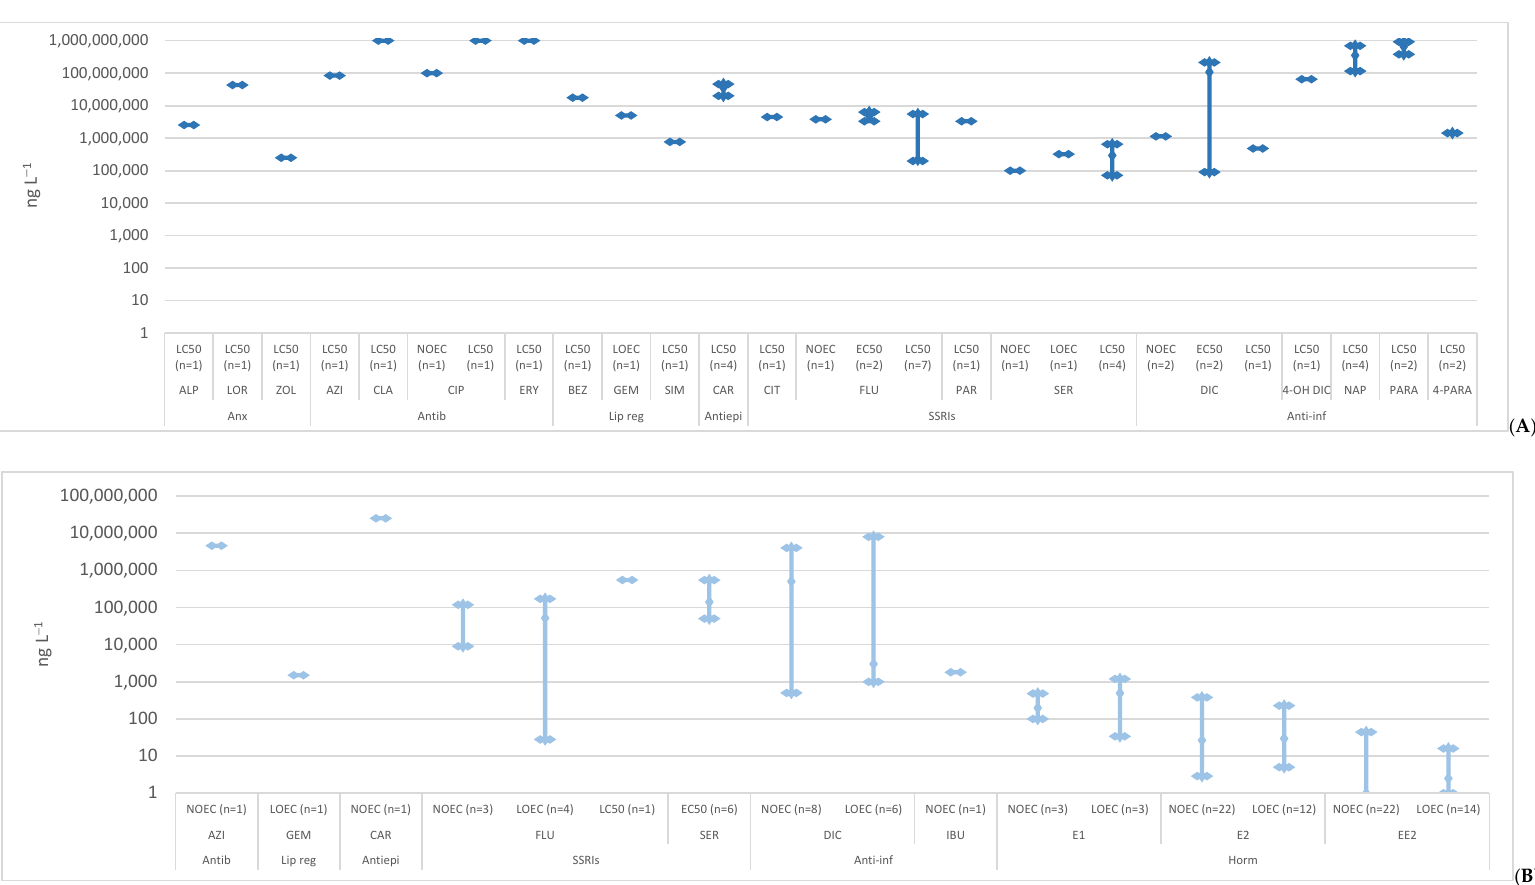
Figure 3. Median, maximum and minimum concentration values reported for acute ( A ) and chronic ( B ) toxicity data concerning fish. (Anx—anxiolytics; Antib—antibiotics; Lip reg—lipid regulators; Antiepi—antiepileptics; SSRIs—Selective serotonin reuptake inhibitors; Anti-inf—anti-inflammatories; Horm—hormones)